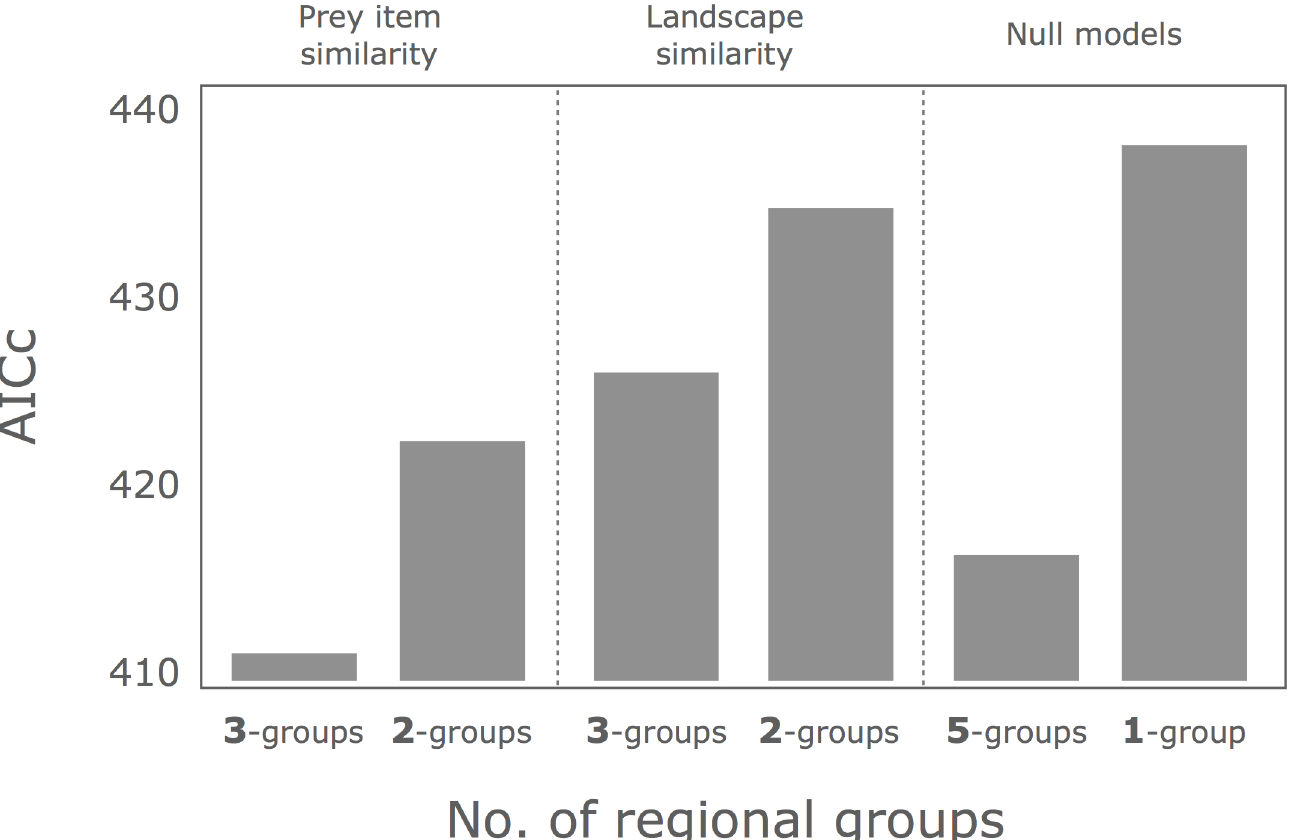
Fig 4. Values of AICc for the best models on hypothetical regional groups according to prey item or landscape similarities. Null model of 5-regional groups means all different study sites were different each other. Null model of 1-group means there was no difference among study sites.